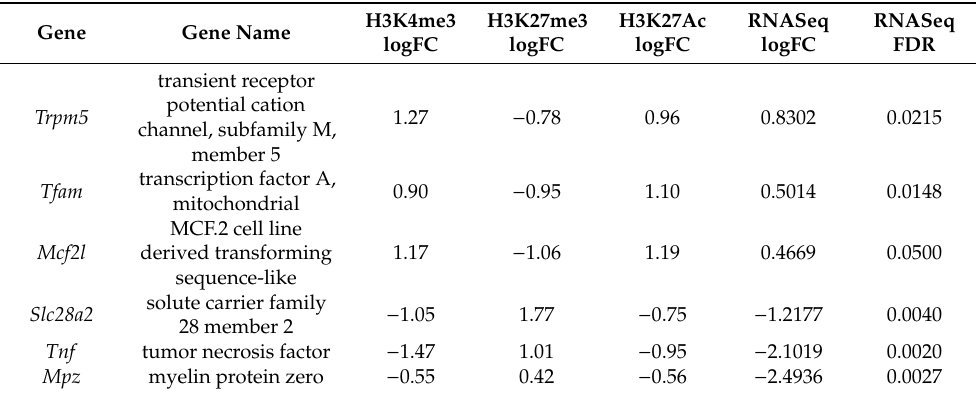
Table 2. Genes potentially regulated by all 3